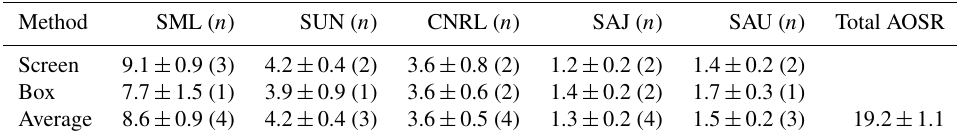
Figure 7. Map image showing interpolated CH 4 mixing ratios for the 16 August total oil sands screen. Table 2. Comparison of emissions rates (in tCH 4 h − 1 ) determined from the screen approach ( n estimates per facility), the box approach ( n estimates per facility) and the uncertainty-weighted average for each method and facility. The five-facility AOSR total is shown in the final column and row.